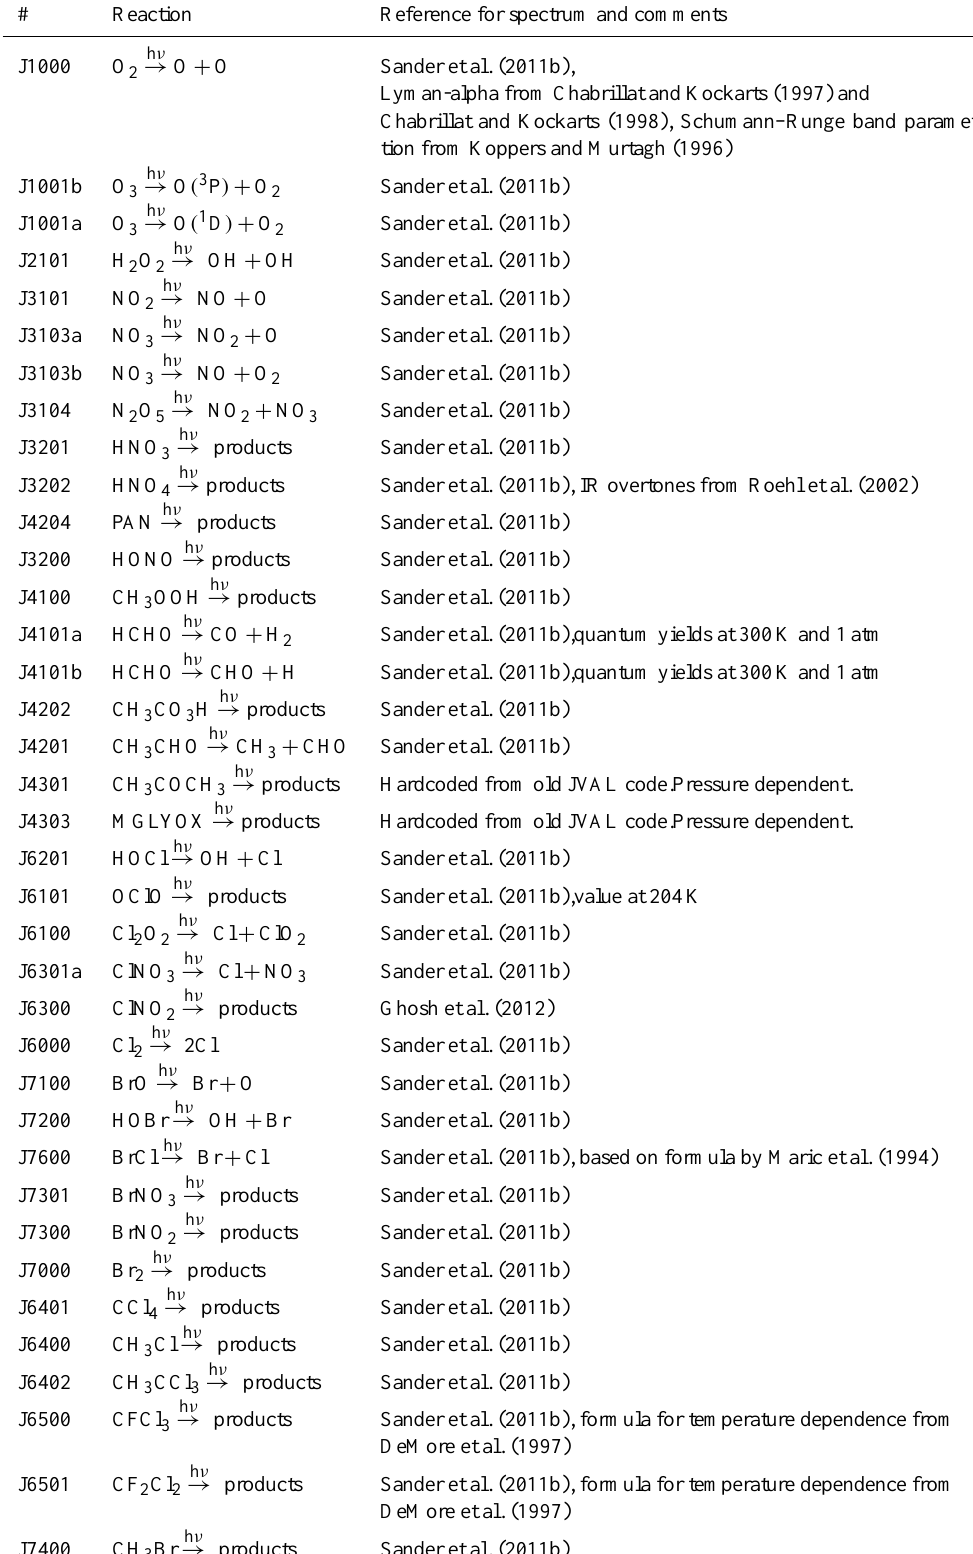
Table 2. JVAL photolysis